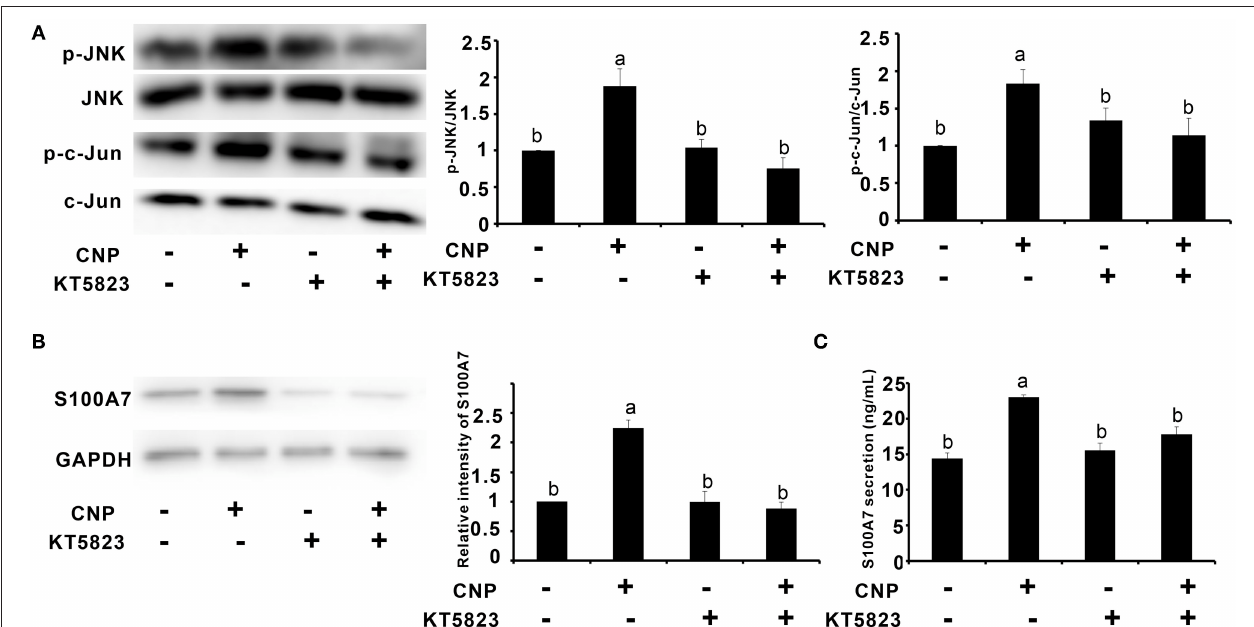
FIGURE 5 | Protein kinase G (PKG) inhibitor KT5823 inhibited the expression and secretion of S100A7 induced by CNP in goat MECs. (A) The Western blotting and quantitative analysis results of relative phosphorylation level of JNK and c-Jun in goat MECs after treatment with 100nM CNP alone or both of 100nM CNP and 1 µ M KT5823 simultaneously for 2h. (B) The Western blotting and quantitative analysis results of S100A7 expression in goat MECs after treatment with 100nM CNP alone or both of 100nM CNP and 1 µ M KT5823 simultaneously for 6h. (C) ELISA results showed the S100A7 concentration in medium in which goat MECs were cultured and treated by 100nM CNP alone or both of 100nM CNP and 1 µ M KT5823 simultaneously for 6h. Different letters indicate significant differences between the groups, P < 0.05. Full-length blots are shown in Supplementary Figures S13–S18